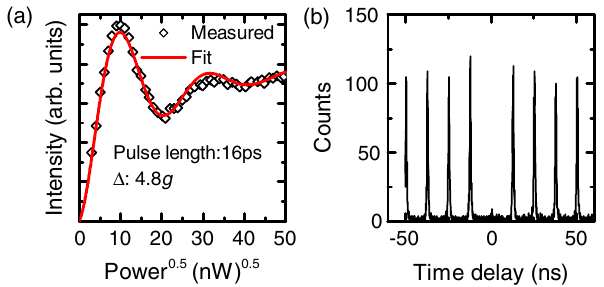
FIG. 4. (a) Rabi oscillation observed upon exciting UP1 and detecting LP1. (b) Measurement of the second-order coherence for exciting UP1 with a π pulse and detecting LP1 yielding g ð 2 Þ ð 0 Þ ¼ 0 . 03 (cid:2) 0 . 01